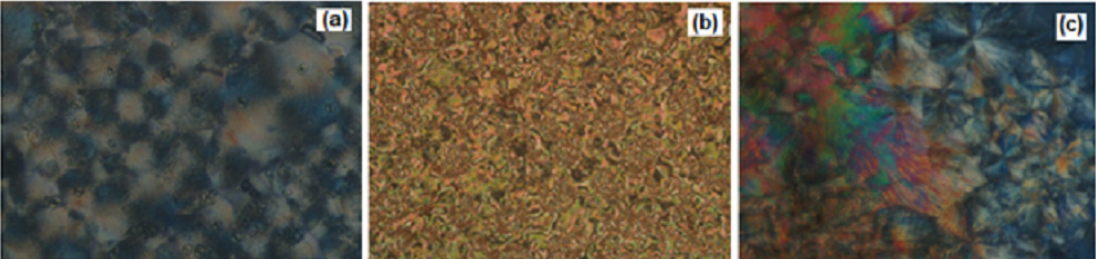
Figure 3. POM textures of 50 mol% of I6/I8 during heating ( a ) SmB phase at 142 °C; ( b ) SmC phase at 150 °C; and ( c ) SmA phase at 158 °C.